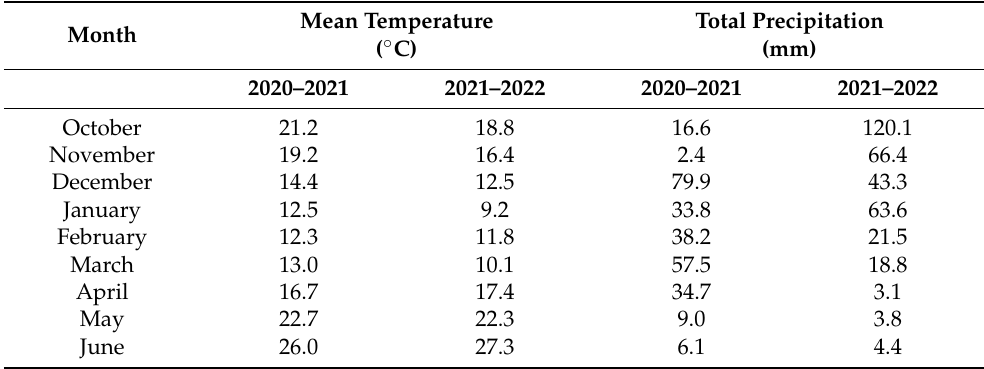
Table 1. Mean monthly temperature ( ◦ C) and total monthly precipitation (mm) observed in the experimental area during 2020–2021 and 2021–2022 growing seasons. Mean Temperature Total Precipitation Month ( ◦ C)